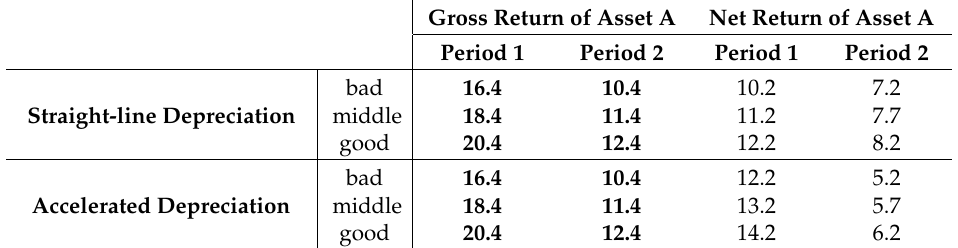
Table 4. Example for gross value equivalence decision situations (i.e., all gross payoffs are identical across the treatments with straight-line and accelerated depreciation; used to test Hypothesis 1).